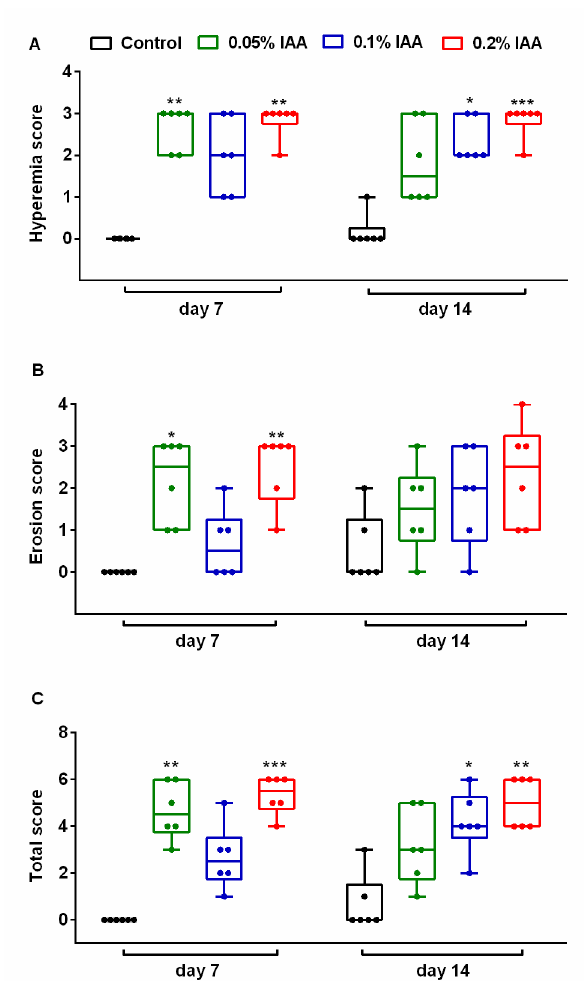
Figure 2. Semi-quantitative macroscopic evaluation of gastric mucosa in Wistar rats. Macroscopic findings, such as ( A ) hyperemia, ( B ) superficial erosions / ulcers and ( C ) total score were evaluated semi-quantitatively. 0.05% IAA induced significant lesions after 7 days, which were less pronounced after 14 days, whereas in the 0.1% IAA-treated group, the peak in macroscopic changes was observed after 14 days. 0.2% IAA induced hyperemia, and erosions developed at both timepoints, although there was no significant difference in macroscopic picture by IAA concentrations. Box plots represent minimum, first quartile, median, third quartile, and maximum values with individual data plots; n = 6 / group. (Kruskal–Wallis followed by Dunn’s multiple comparison test to observe intergroup differences at given timepoints, * p < 0.05, ** p < 0.005, *** p < 0.001 vs. control group; Mann–Whitney test was performed to analyze intragroup differences by time—not significant).